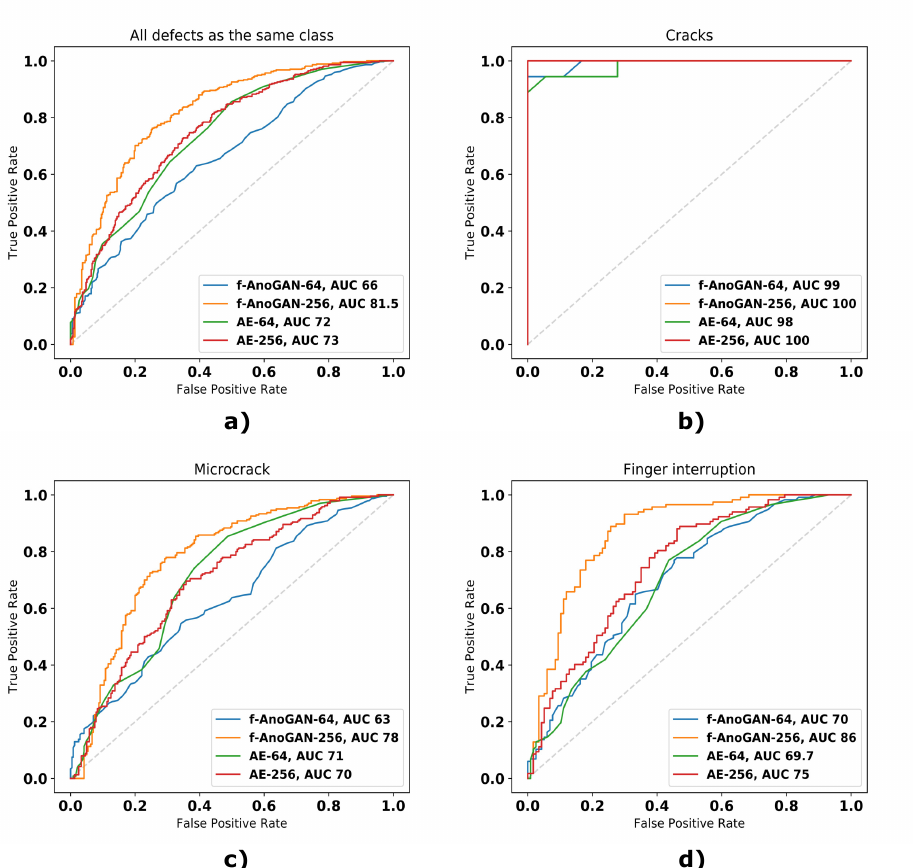
Figure 7. ROC curves from the different models in the unsupervised part experiments. ( a ) Results considering all defects as they belong to the same class, ( b ) results with defective samples with cracks, ( c ) results with defective samples with microcracks, ( d ) results with defective samples with finger